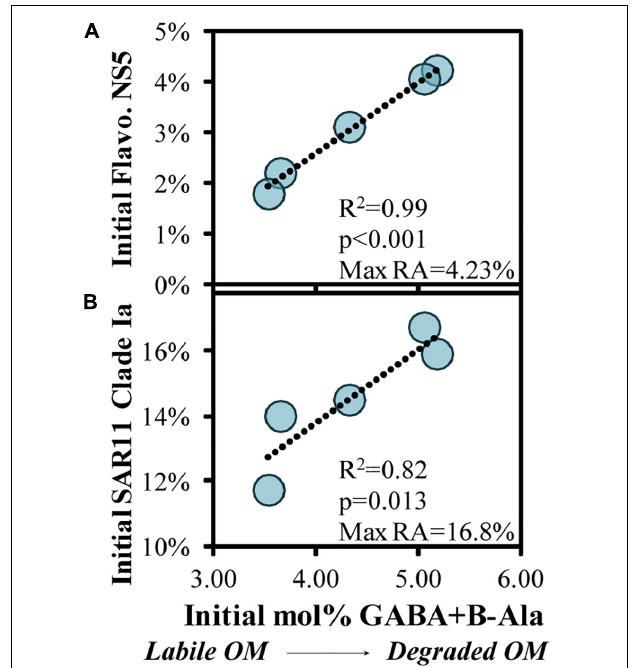
FIGURE 8 | Significant ( p < 0.05) correlations between the initial THAA-based mol% GABA + B-Ala and initial relative abundances of an ASV within the Flavobacteriaceae NS5 (A) and SAR11 Clade Ia genera (B) , collected in the surface OM remineralization experiments. The SAR11 Clade Ia in (B) was the most abundant ASV among the surface experiments. Noted within each figure are the maximum relative abundances (RA) detected for each